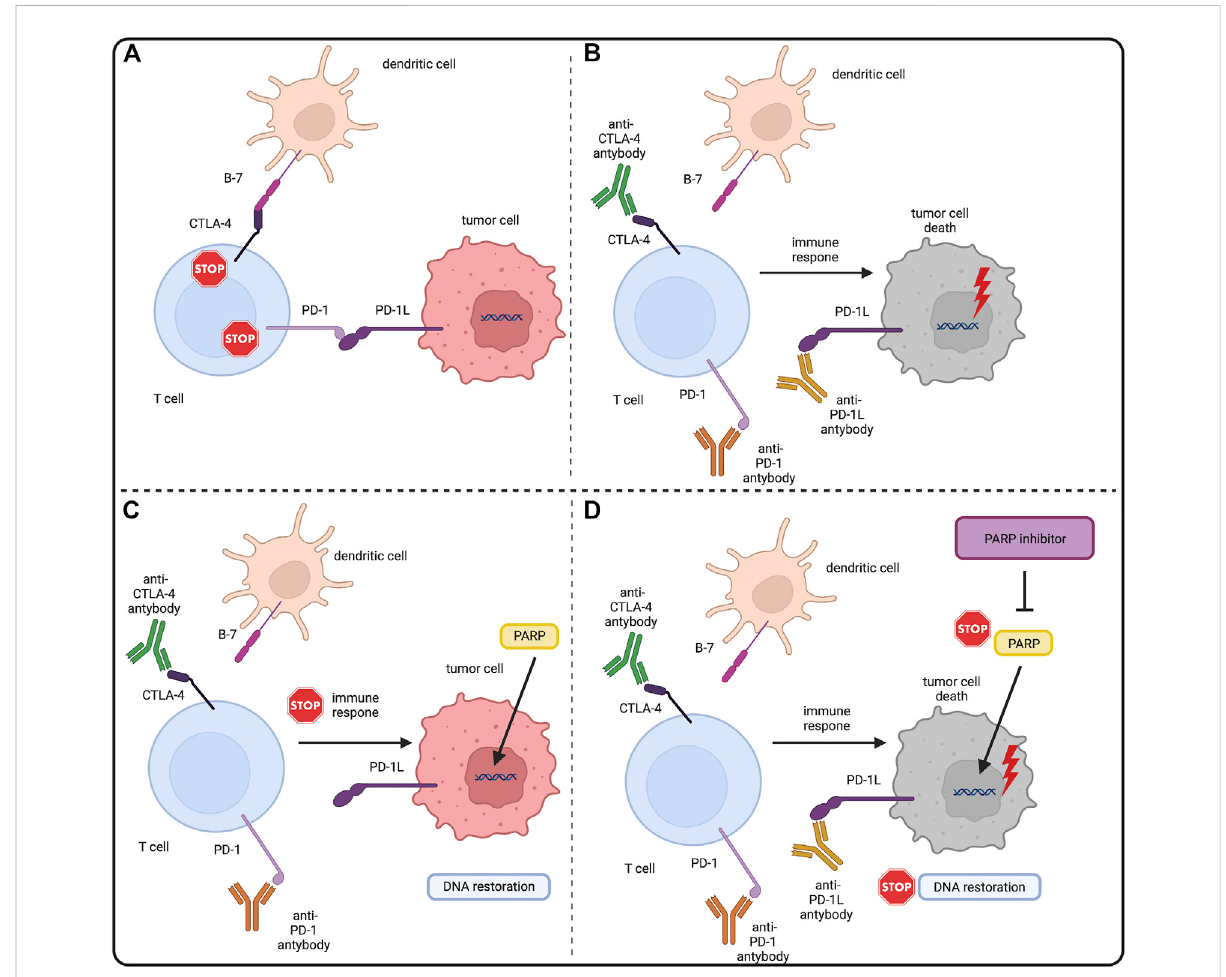
FIGURE 3 PARP inhibitors and immune checkpoint inhibitors – molecular rationale. (A) CTLA4 and PD1 are surface molecules present on T-cells. CTLA4 binds with the B7 molecule and PD1 binds with PD-L1 present on antigen presenting cells (APCs) and tumor cells. This downregulates the immunogenic response of both T-cells, allowing tumor cells to grow. (B) Immune checkpoint inhibitors (ICIs) by binding with CTLA4 and PD(L) 1 block the downregulation of T-cells allowing them to eliminate tumor cells with the immune response. Also tumor cells genome instability makes them also more prone to the tumor mutation burden (TMB) and mutation overload leads to their death. (C) PARP role in DNA restoration allows tumor cells to repair DNA lesions and mitigate the TMB, eventually enabling them to evade the immune response. (D) PARP inhibitors by blocking the PARP DNA repair pathways in tumor cells stop the DNA restoration processes, exposing tumor cells to the immune response of T-cells under the treatment of ICIs. Created with